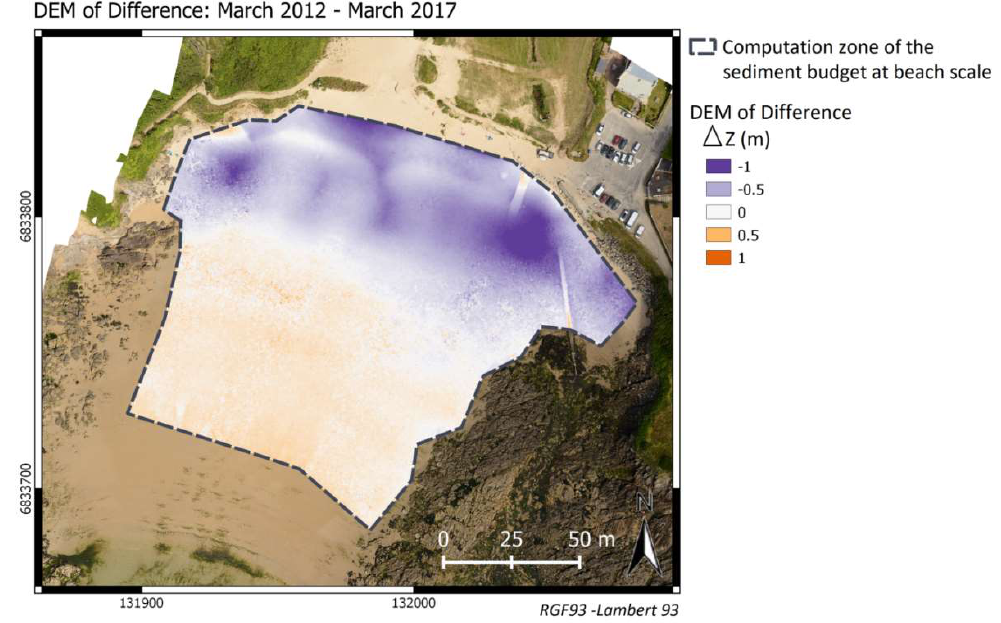
Figure 8. DoDs over the period from March 2012 to March 2017.